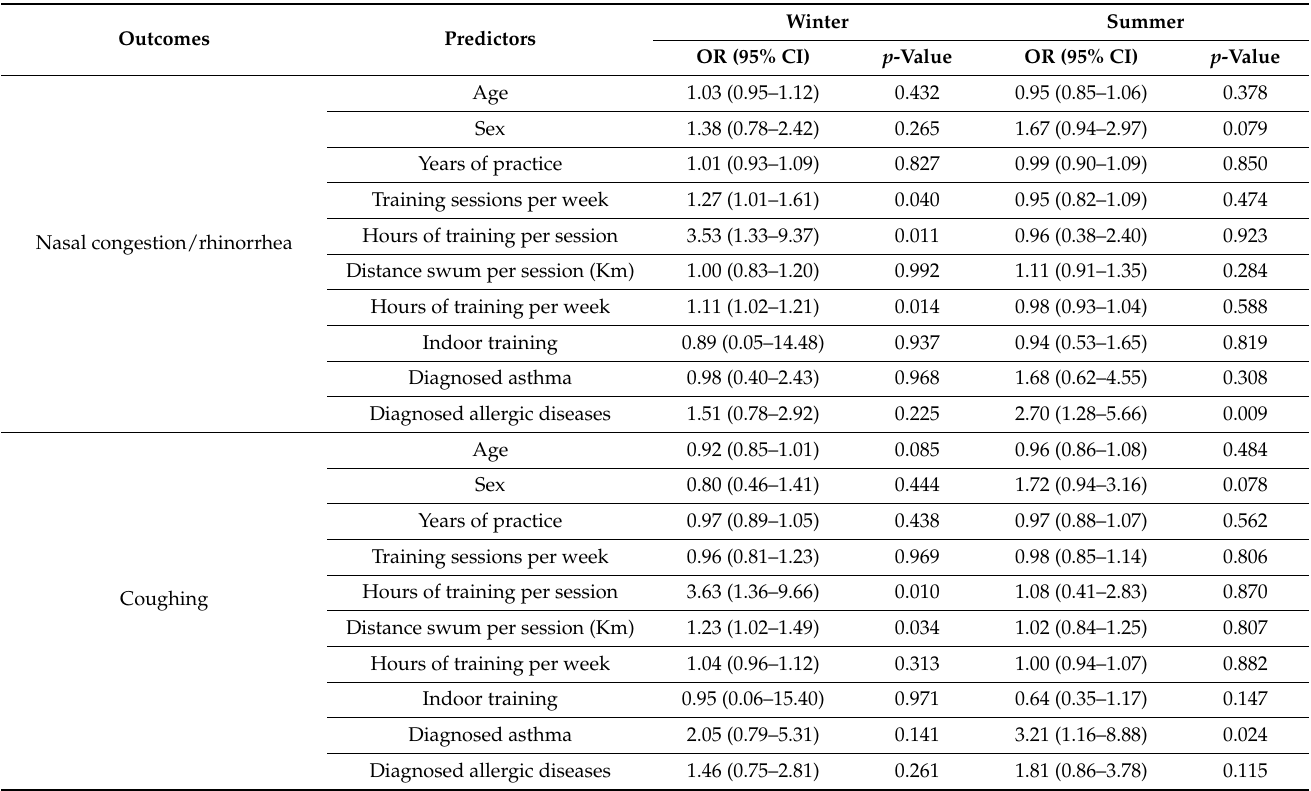
Table 2. Results of simple logistic regression analysis in the participants grouped according to the